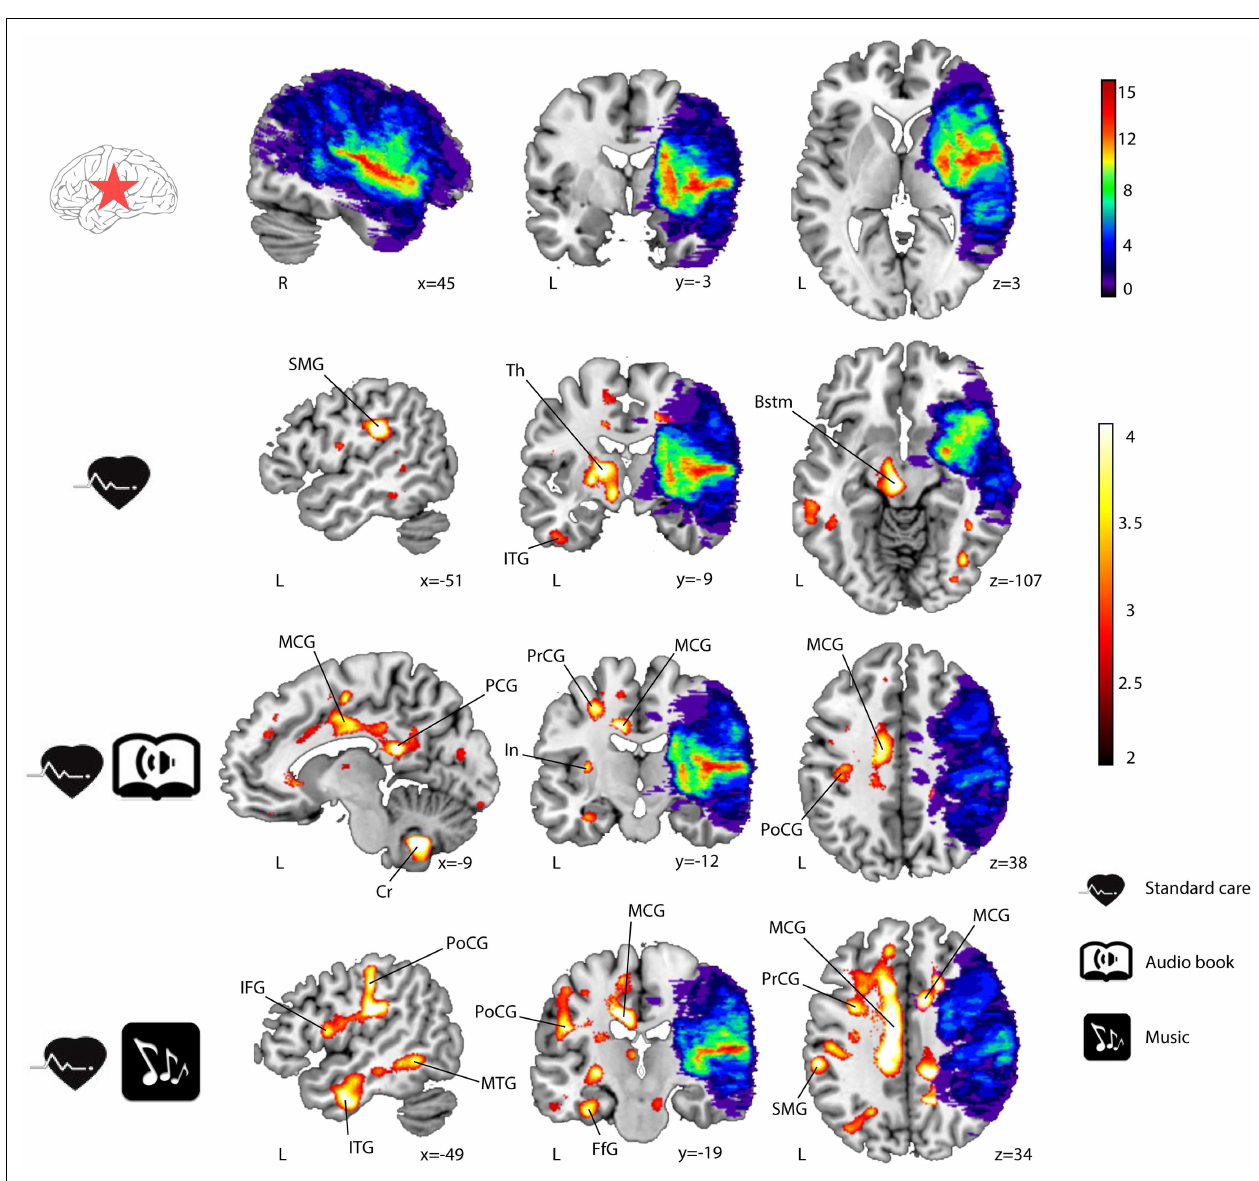
right of each slice. Only clusters surviving a p < 0.001 threshold are labeled (see also Table 4 ). SMG, supramarginal gyrus;Th, thalamus; ITG, inferior temporal gyrus; Bstm, brainstem; MCG, middle cingulate gyrus; PCG, posterior cingulate gyrus; Cr, cerebellum; PrCG, precentral gyrus; In, insula;